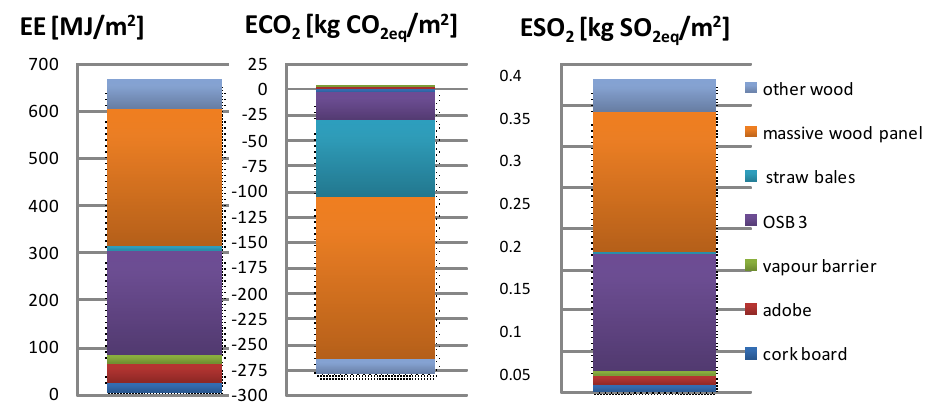
Figure 10. Floor structures: Materials share by percentage and impact on environmental indicators.